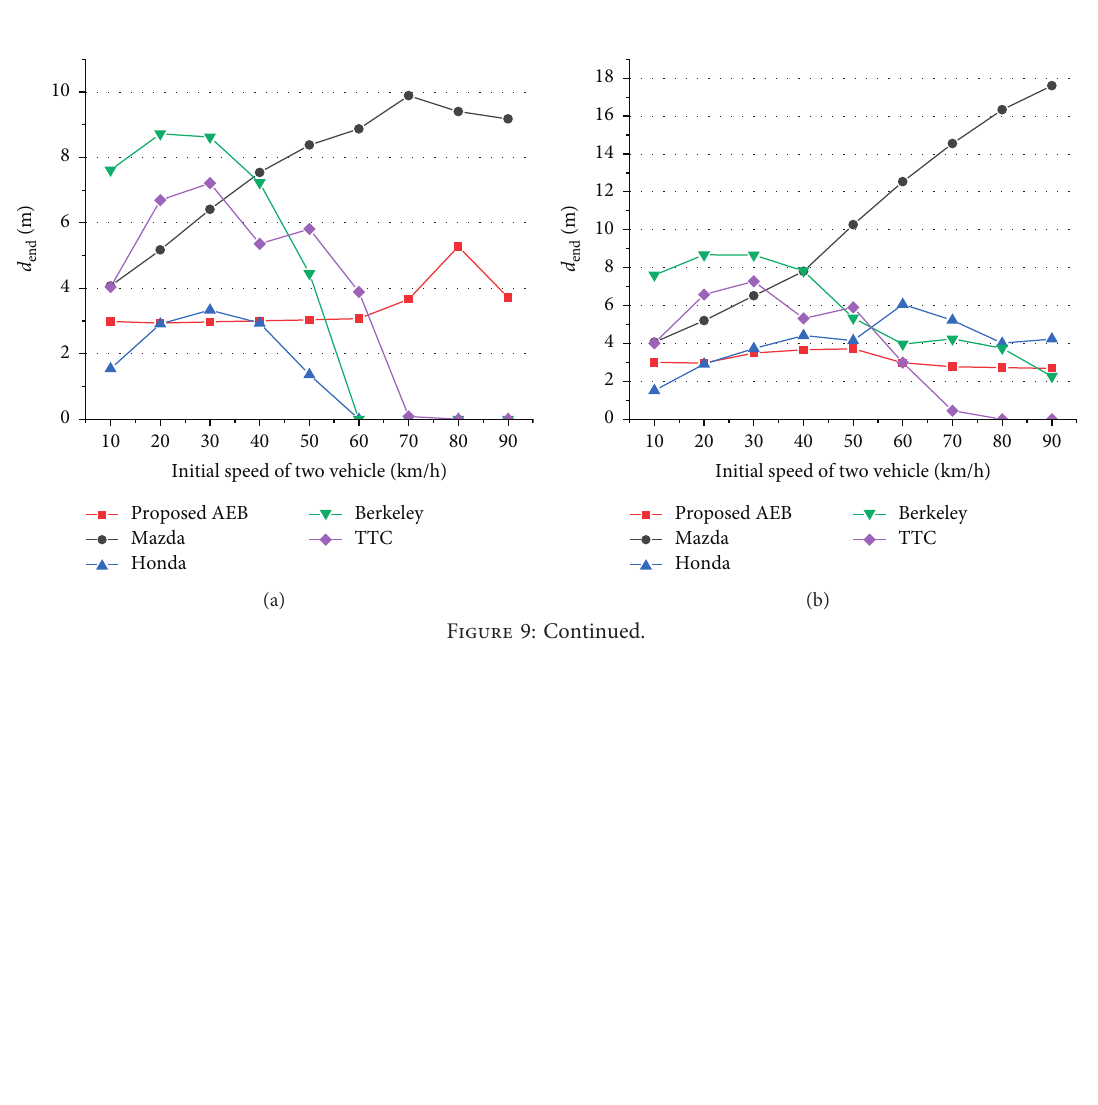
Figure 8: The shortest relative distance between two vehicles in the CCRm scenario